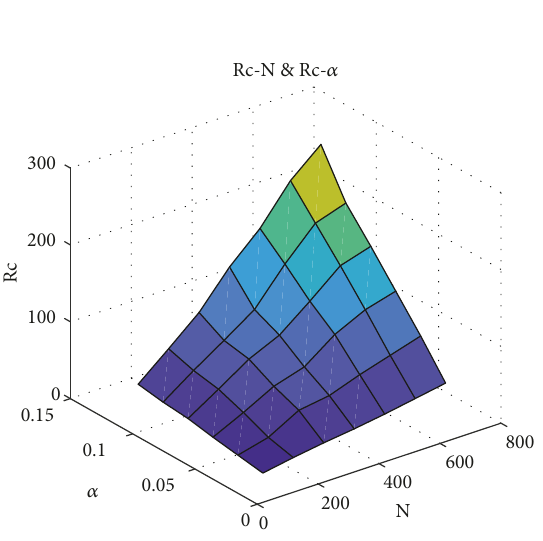
Figure 9: Phasetransition of theIsing-Stockmodel. 𝛼 = 0.05 , 𝛽 = 1 , and 𝑆 𝑝 = 0. In this example, the critical point is 𝑅 𝑐 = 38 . Figure 10: The impact of